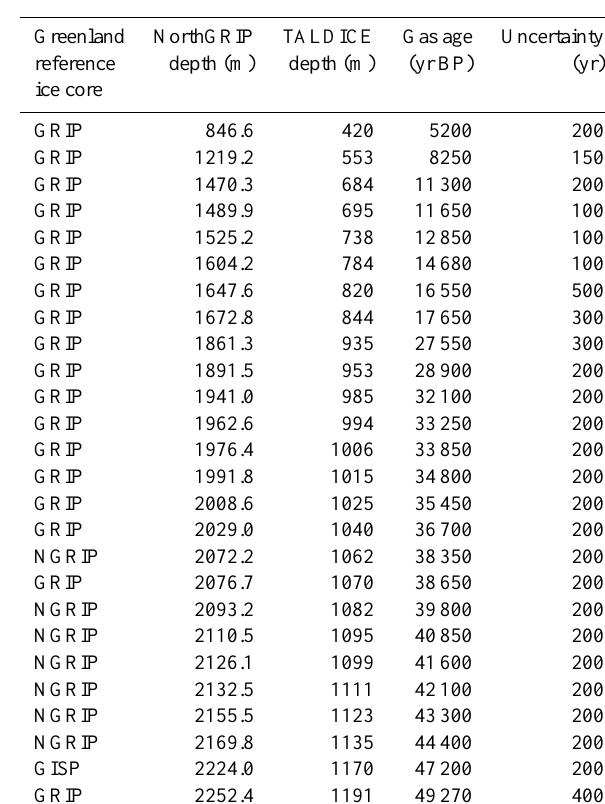
Table 1. Tie points defined by CH 4 record synchronization between TALDICE and Greenland ice cores on GICC05 age